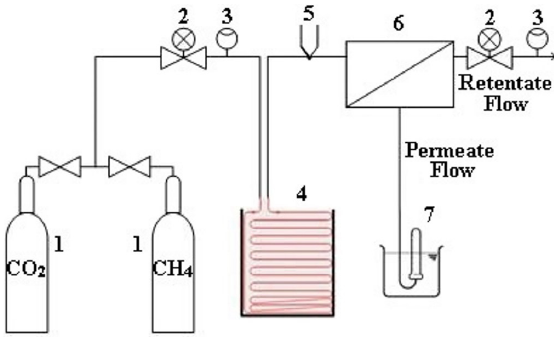
Figure 1 - Gas Permeation System. 1 – Feed gas cylinder; 2 – Pressure controller valve; 3 – Rotameter; 4 – Thermostatic bath; 5 – Thermocouple; 6 – Permeation cell; 7 – Soap bubble flow